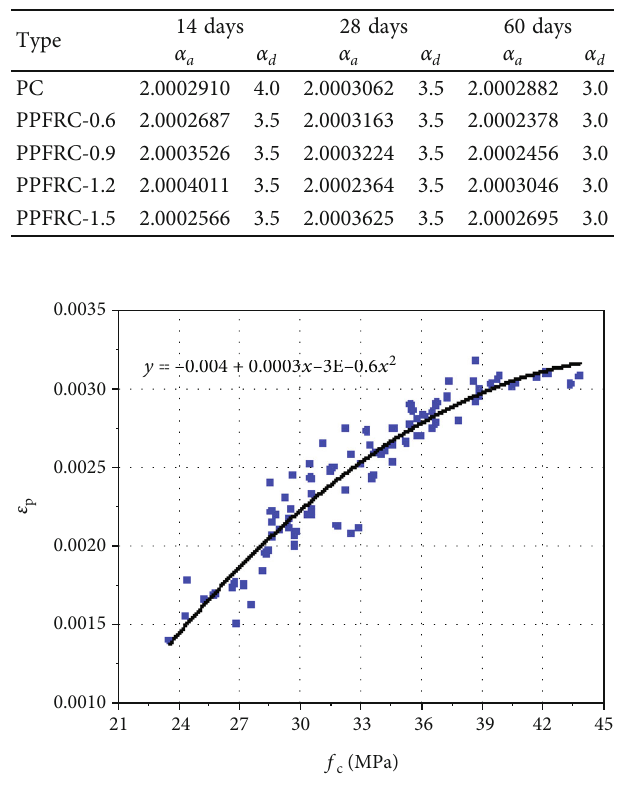
α a and d values after improved